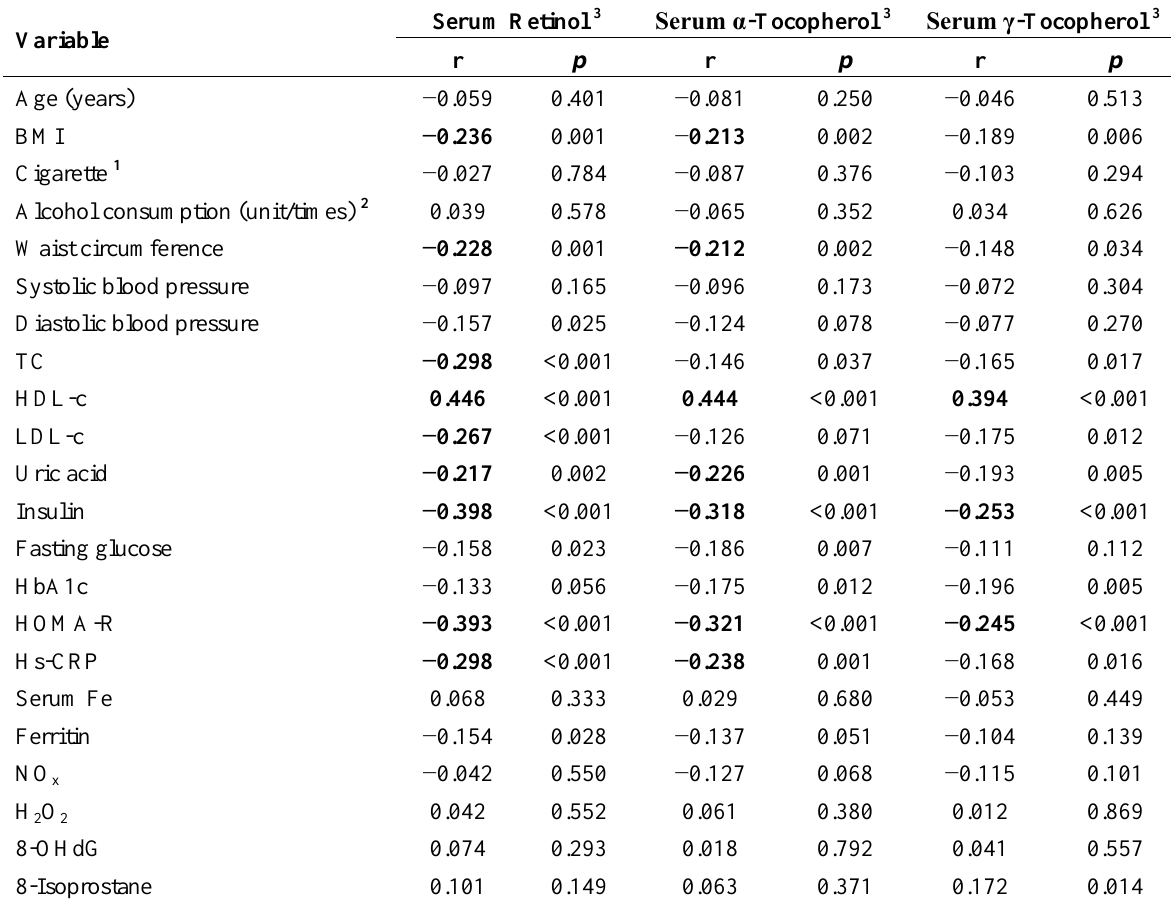
Table 3. Spearman’s correlation of serum vitamins with each